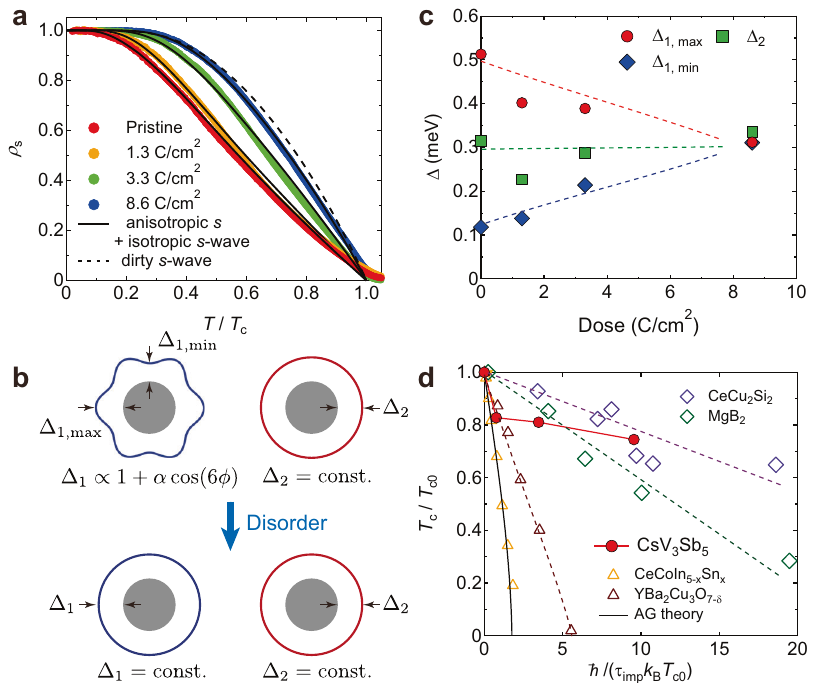
Fig. 3 | Pair-breaking effect in CsV 3 Sb 5 . a The Temperature dependence of nor- malized super fl uid density ρ s ( T ) ≡ λ 2 (0)/ λ 2 ( T ) for the pristine (red), 1.3 (orange), 3.3 (green), and 8.6 (blue) C/cm 2 irradiated samples. Black solid lines are the fi tting curvesofthemultigapmodel(cleanlimit).Theblackdashedlineisthecurveforthe dirty s -wave (single gap) case. Note that ρ s ( T ) for the 8.6 C/cm 2 irradiated sample with the relatively large value of ξ / l =2.3 approaches the dirty limit (see Supple- mentary Information Sec. V). b Schematic picture of the change in the super- conductinggapstructureagainstdisorder.Theintroductionofelectronirradiation changes the anisotropic superconducting gap structure to an isotropic one. c Gap sizes obtained from the fi tting analysis of the super fl uid density as a function of dose.Red circlesand bluediamonds represent themaximumand minimumvalues